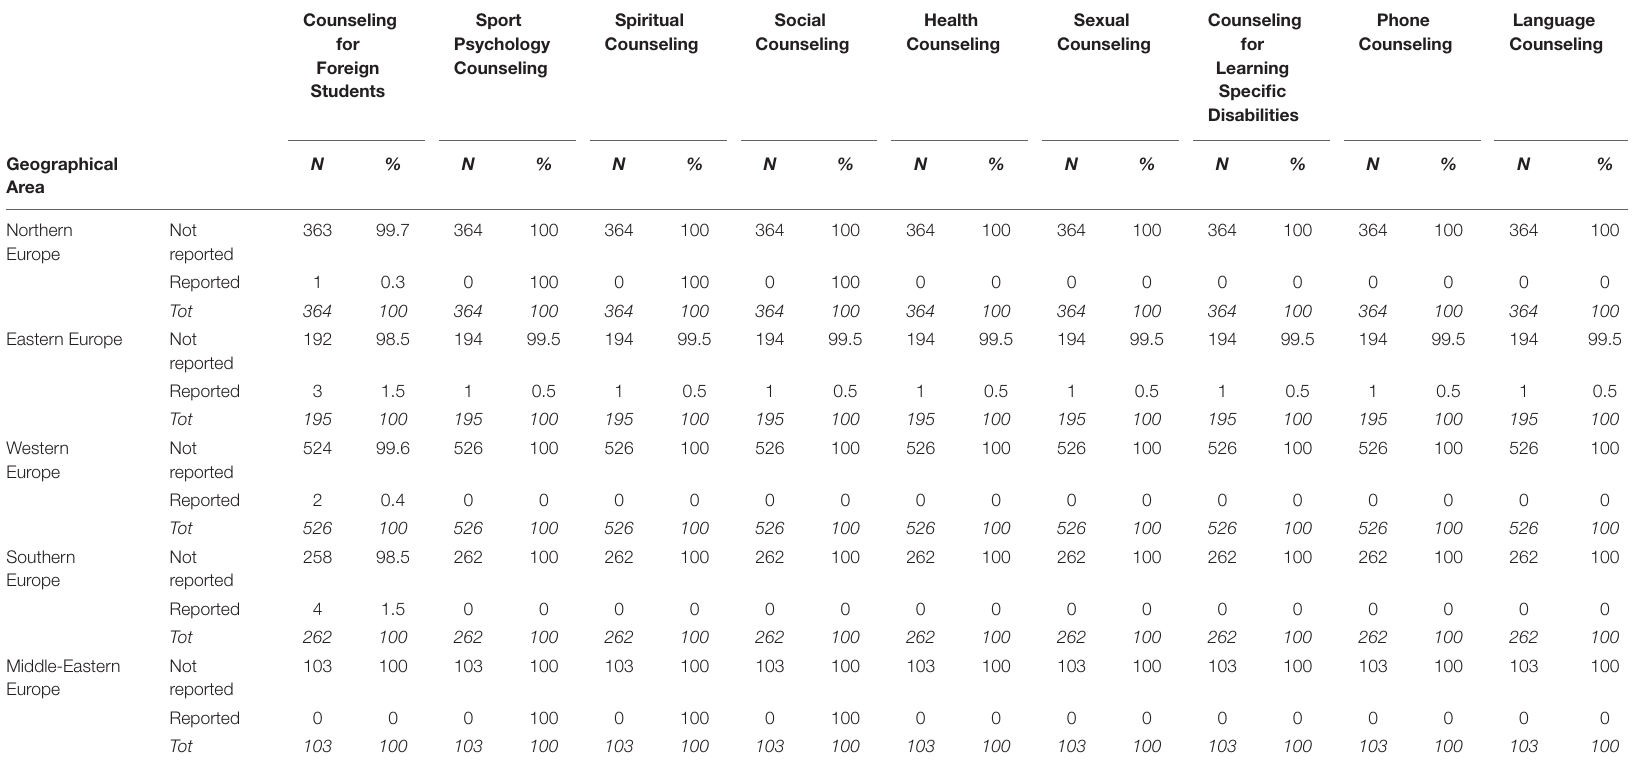
TABLE 9 | Service offered by students counseling centers in different European